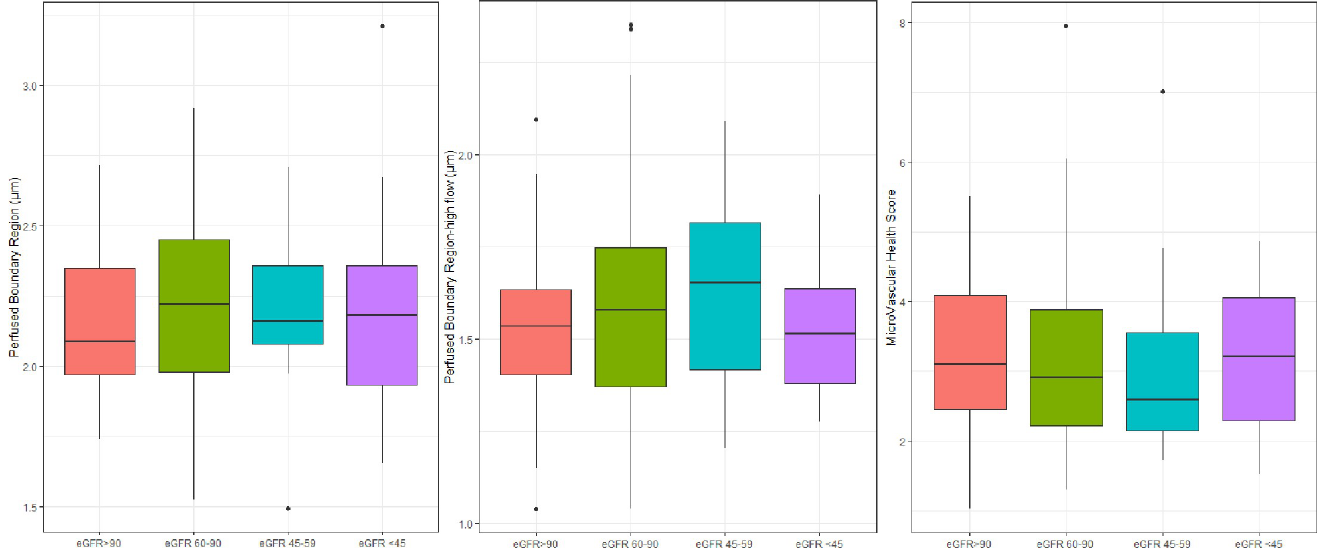
Fig 4. Glycocalyx measurements in participants divided into groups according to eGFR level. Perfused Boundary Region (p = 0.86), Perfused Boundary Region- high flow (p = 0.53) and MicroVascular Health Score (p = 0.999). P-values are for the unadjusted analyses.